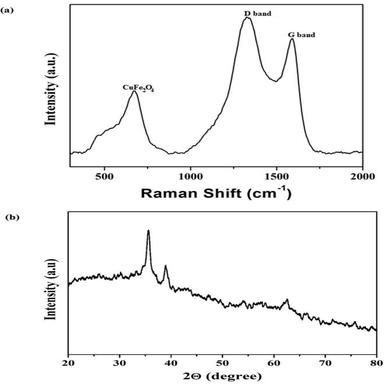
(a) XRD profile, (b) Raman spectra of FLPWAC composite.